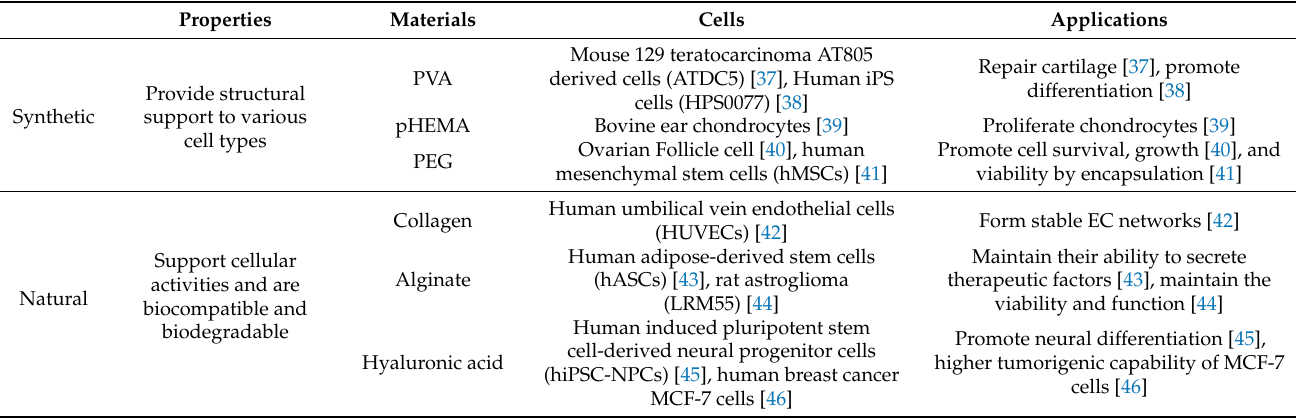
Table 2. Synthetic and natural hydrogels for 3D cell